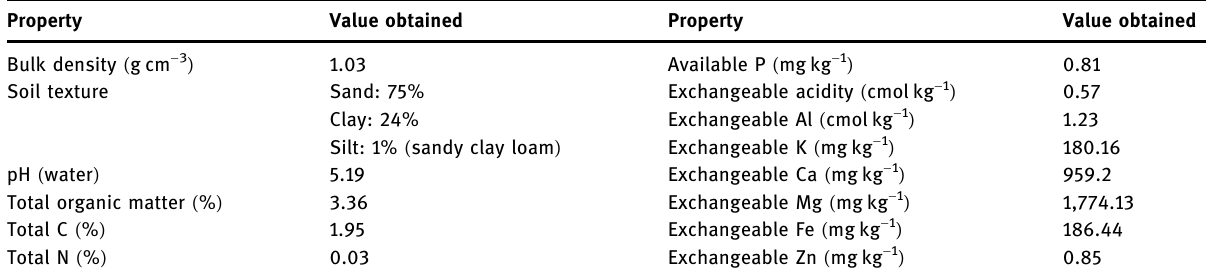
Table 1: Selected physicochemical properties of soil Property